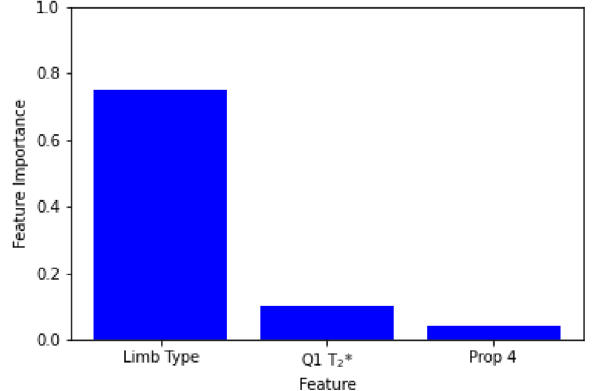
Figure 1. RFE-CV feature importance results (Q1 T 2 * = 1 st quartile T 2 *, Prop 4 = sub-volume proportion 4).